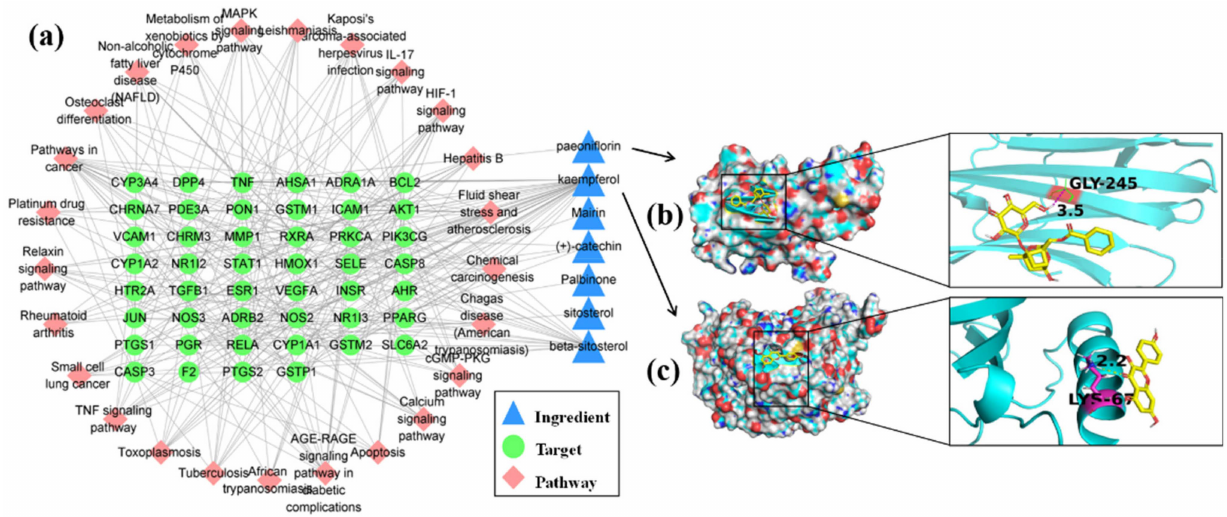
Figure 7. Network pharmacological target prediction and molecular docking simulation of active ingredients contained in B. ( a ) Ingredient-target-pathway network. ( b ) The binding mode of the representative ingredient paeoniflorin and the target TNF. ( c ) The binding mode of the significant ingredient kaempferol and the target